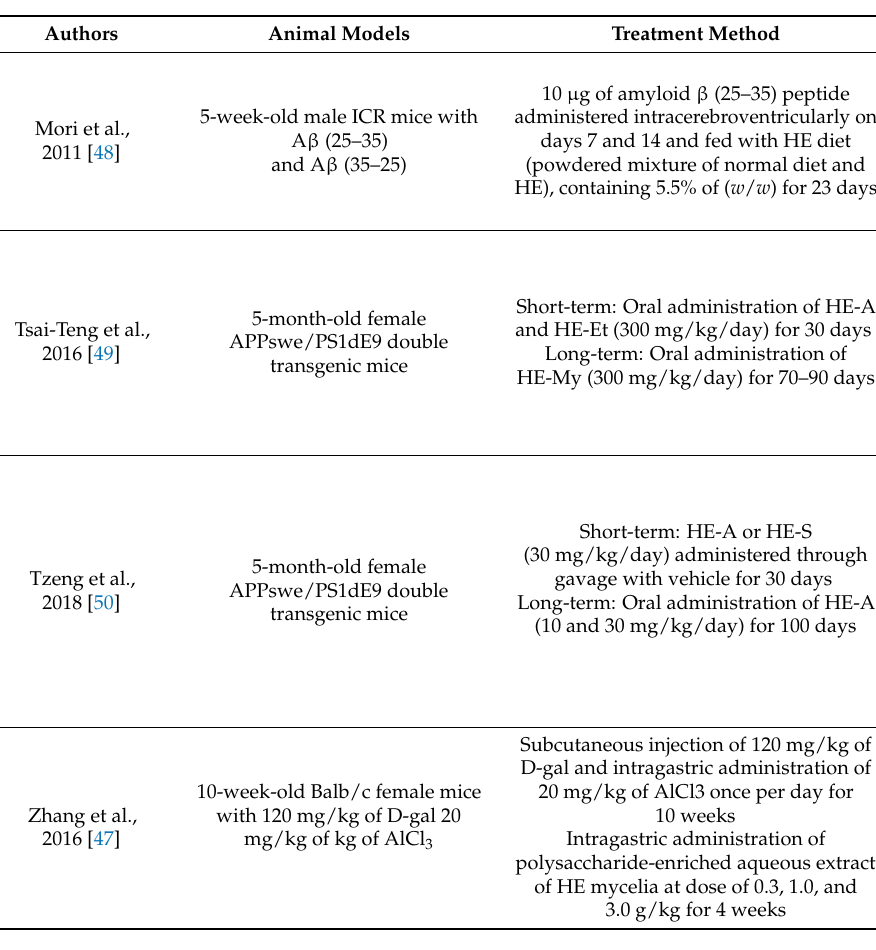
Table 1. Preclinical studies of Hericium erinaceus in AD animal